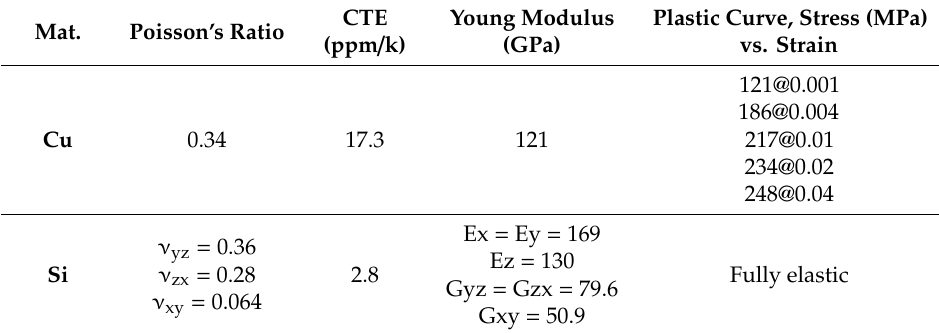
Table 1. Mechanical properties of the materials in the simulation.